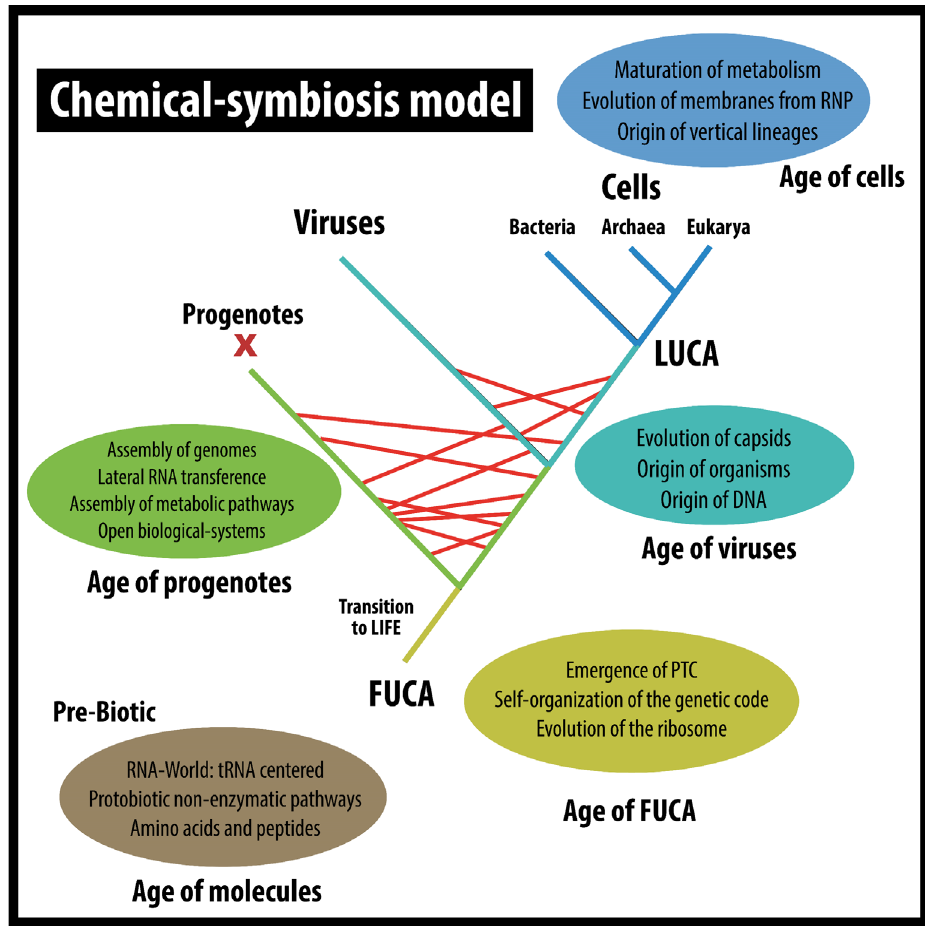
Figure 2 - The chemical symbiosis model: a RiboNucleoProtein scenario for the origin of biological systems. The ages and their most conspicuous features are highlighted in the balloons. Previously to the origin of cells, reticulated evolution operated by lateral transference of genetic material (red